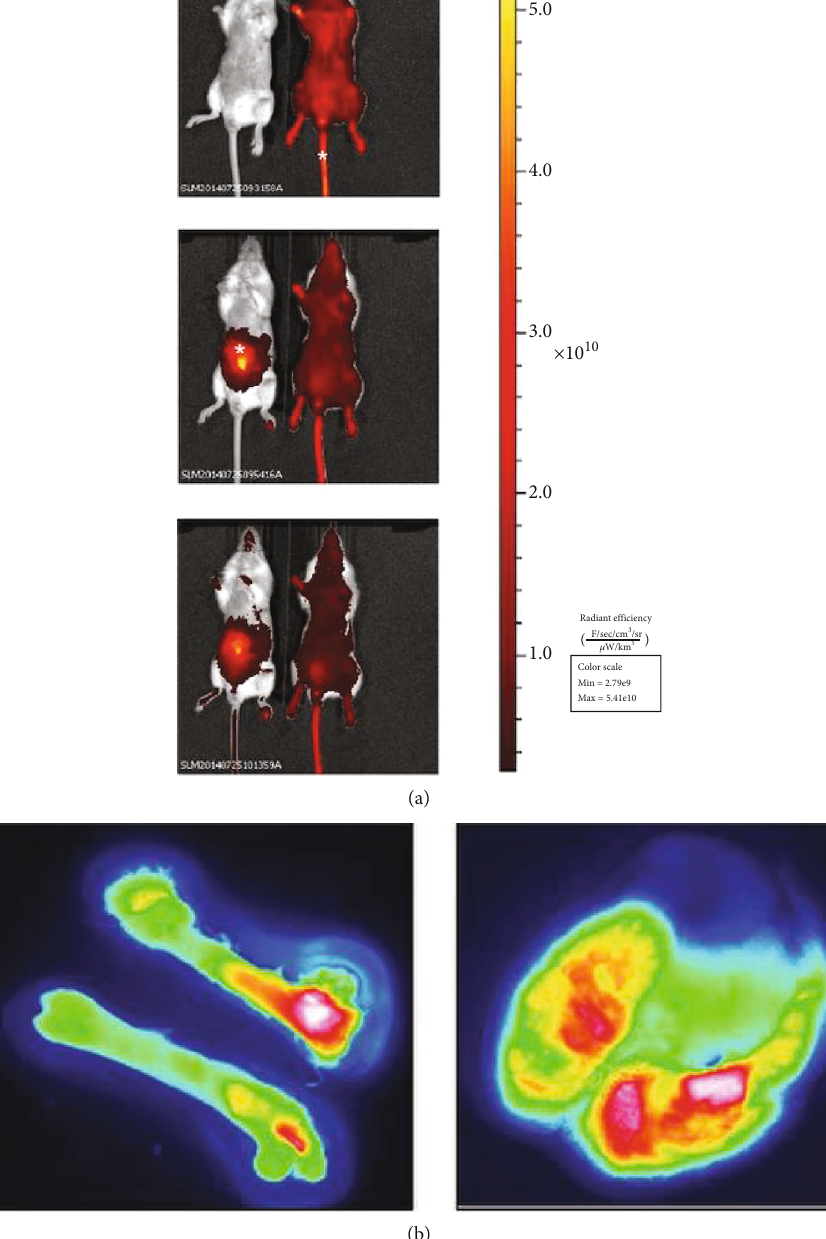
Figure 4: Female BALB/c mice were inoculated with 1mg/kg of Alexa 647-loaded nanospheres dissolved in sterile saline and monitored for fl uorophore distribution (a) systemically over 30 minutes (images presented by time from top [initial tail vein injection], middle [initial i.p. injection], to bottom [30 minutes postinjection]) via IVIS imaging through i.p. (left) and tail vein (right) injections ( ∗ indicates IVIS signal immediately following either injection) and (b) in the bone (left) and lung (right) at four hours postinjection via fl uorescent